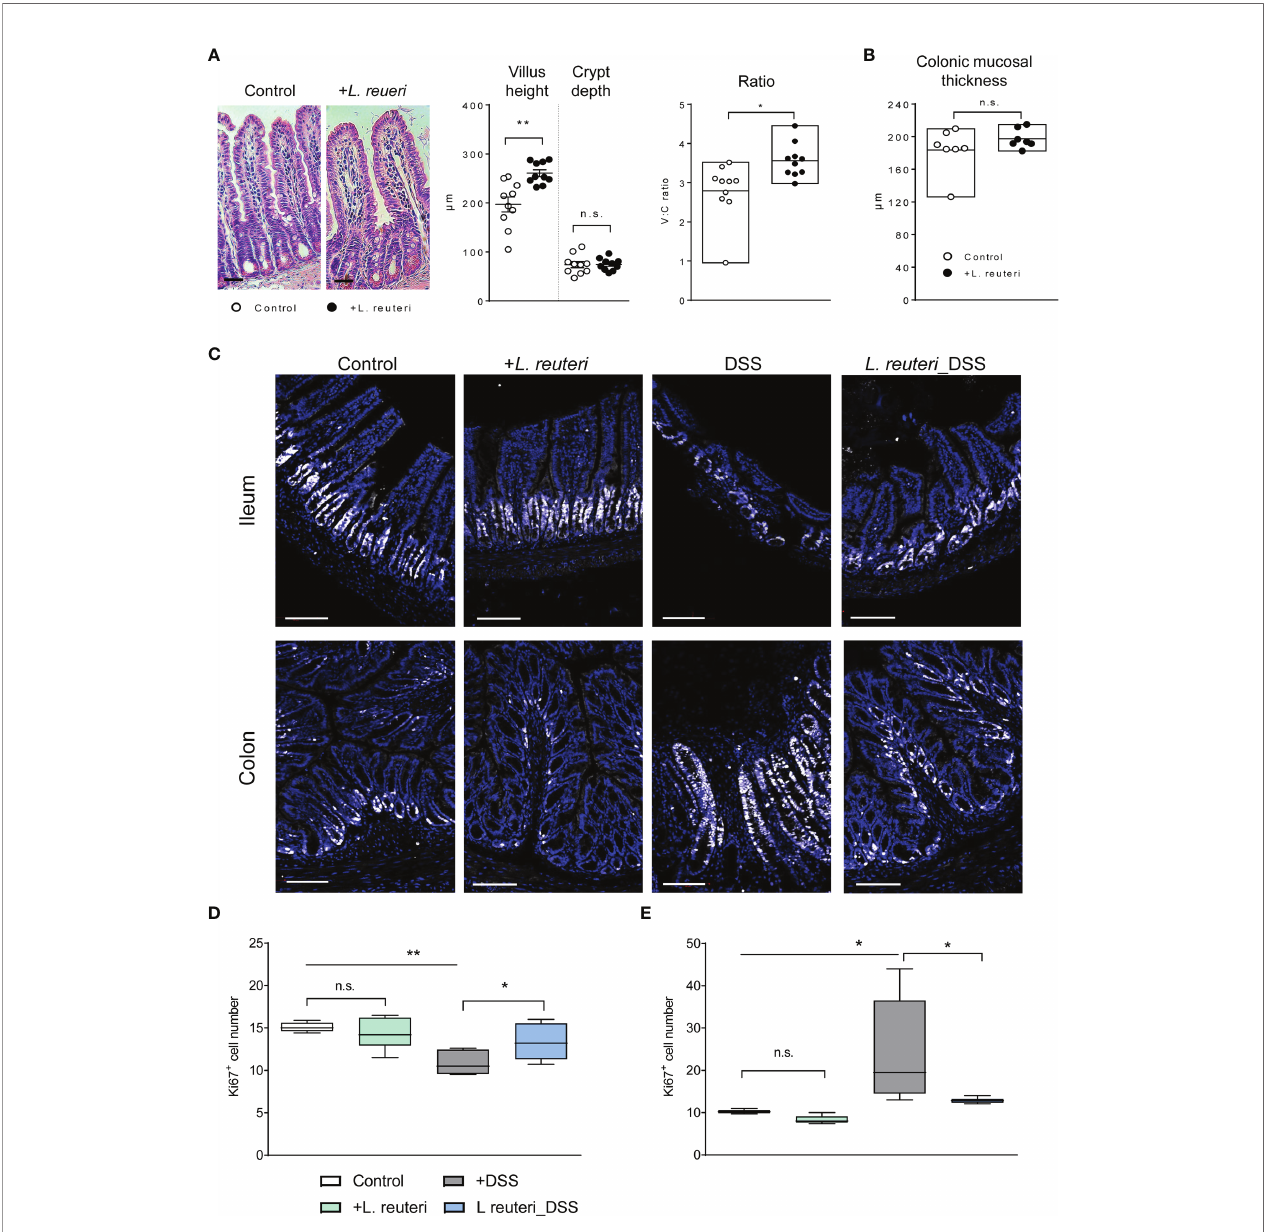
FIGURE 7 | Alterations of intestinal histological parameters and proliferation in response to L. reuteri during DSS-induced colitis in young mice. (A) Representative images of ileum of mice. Villus height and crypt depth were measured, and the ratio V:C was calculated, as well as the mucosal thickness of the colon (B) . (C – E) Analysis and quanti fi cation of proliferating cells. (A) Representative staining of ileum (upper panels) and colon (lower panels) with anti-Ki67 (white) and Hoechst (blue). The number of Ki67 + cells per villi-crypt unit was measured (n = 6 mice per group, two slides per mouse). Scale bar = 50 µm. Data are presented as mean ± SEM. * p < 0.05, ** p < 0.01 using ANOVA with Tukey ’ s post-hoc test. DSS, dextran sulfate sodium. ns, non signi fi